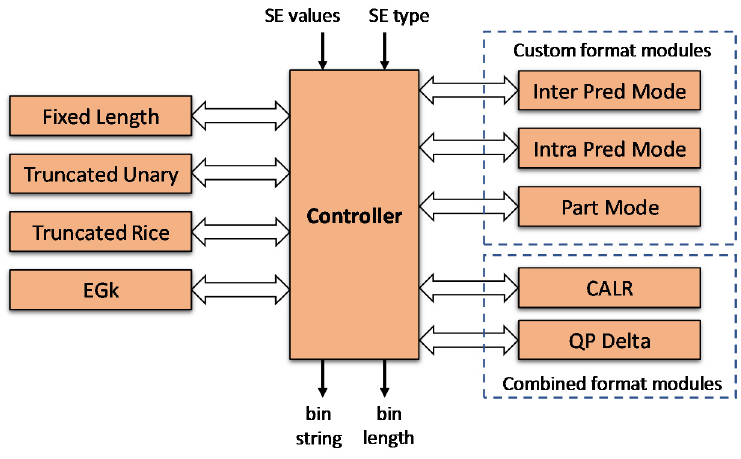
Figure 2. General hardware architecture of a binarizer [4].